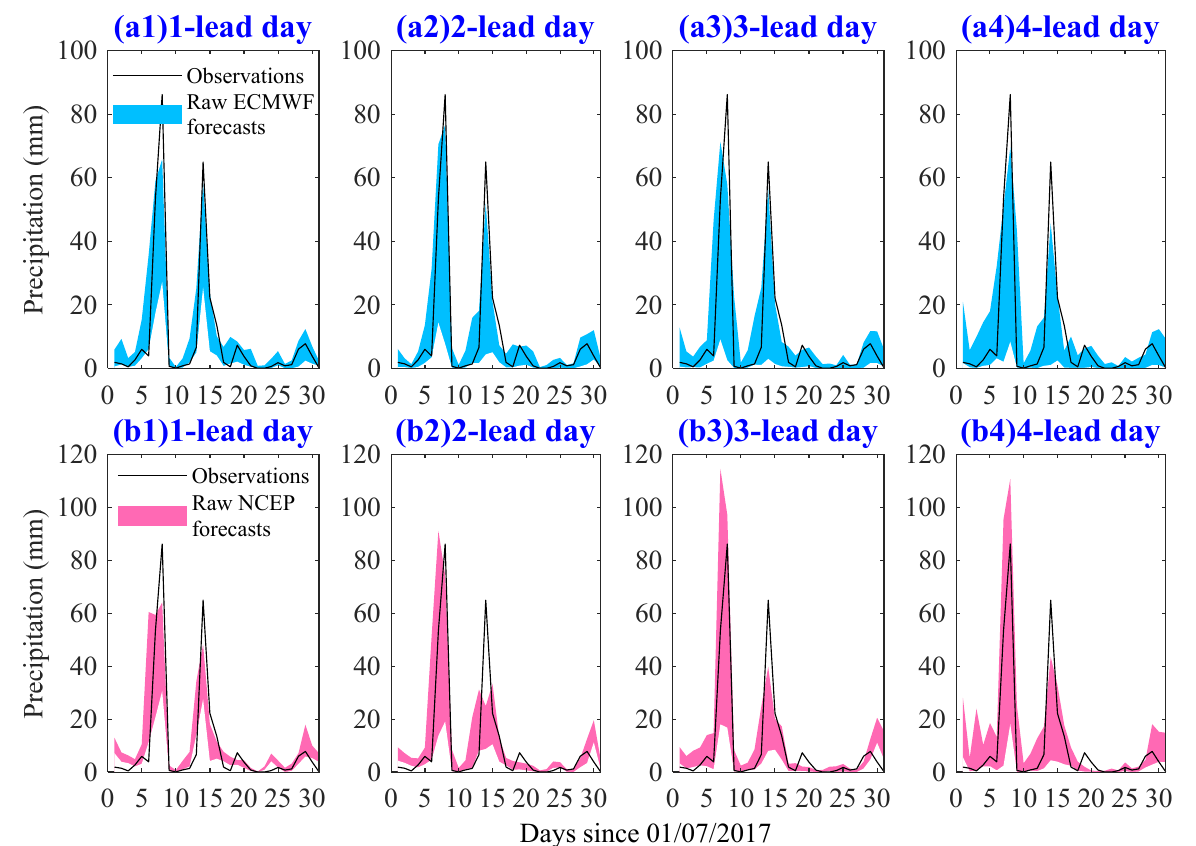
Figure 9. Comparison of time series of precipitation obtained from basin-averaged raw ECMWF (blue color) and NCEP (pink color) at 1, 2, 3, and 4 lead days, with observed precipitation. The shaded area represents the 5th–95th percentile values obtained from 1000 postprocessed